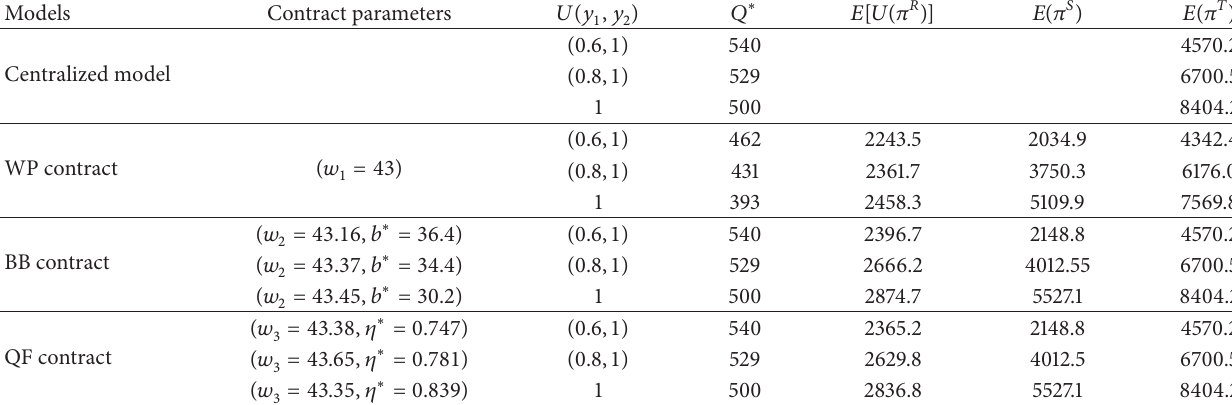
Table 3: Impact of yield uncertainty on the supply chain ( 𝜆 = 2 , 𝛽 1 = 𝛽 2 = 0.5 ).